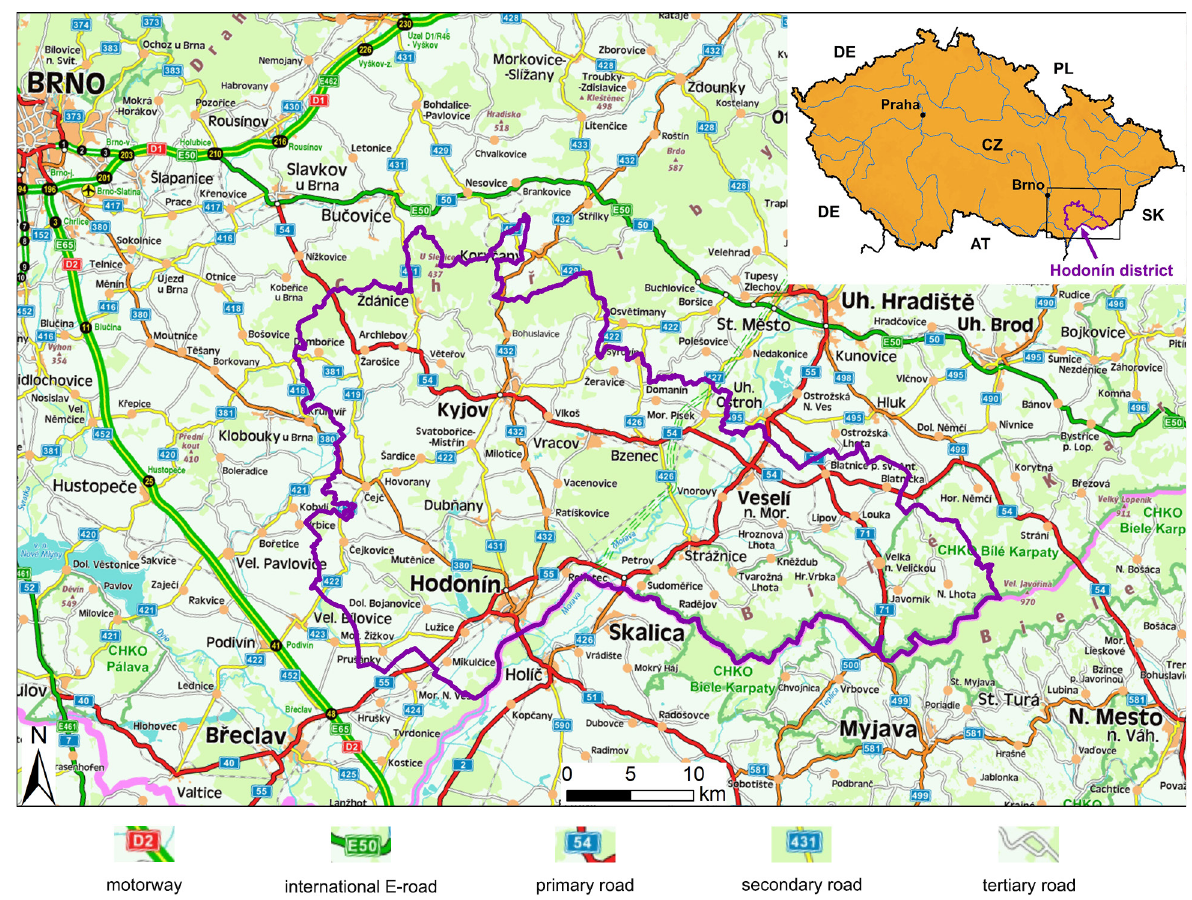
Fig. 1. The Hodonín model region and surroundings with important roads. Source: Czech National Geoportal, CENIA,